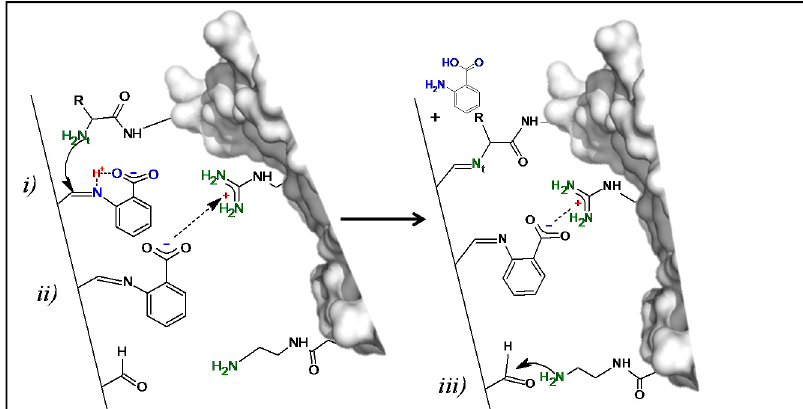
Figure 3. Proposed one-pot mechanism of the generation of a bifunctional Gx support and enzyme immobilization. (Left) Bifunctional surface formed after AA reaction with the Gx support; the immobilized additive molecules could interact with the enzyme through covalent nucleophilic catalysis [34,35] (i) and/or through cationic exchange (ii) triggering enzyme immobilization. (Right) The increased proximity between the immobilized enzyme reactive groups and the support promotes additional covalent bonds (iii) constituting a multipoint attachment immobilization. Representations made with Pymol version 1.3.